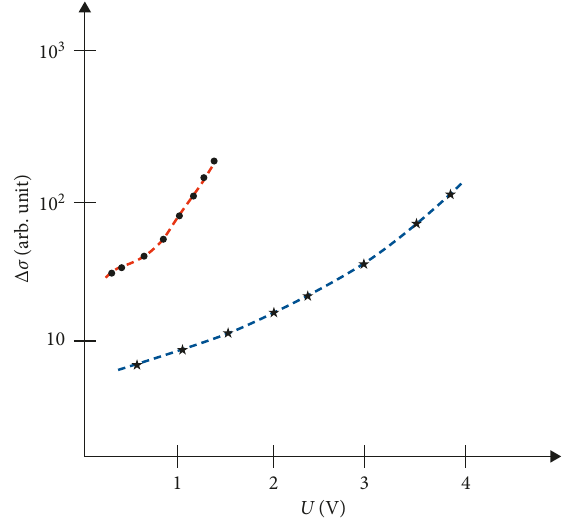
Figure 17: Dependence of the CR PES line intensity on the applied voltage U of the sample 6 at T where the curves marked by • and and ε H , correspondingly. ⊥